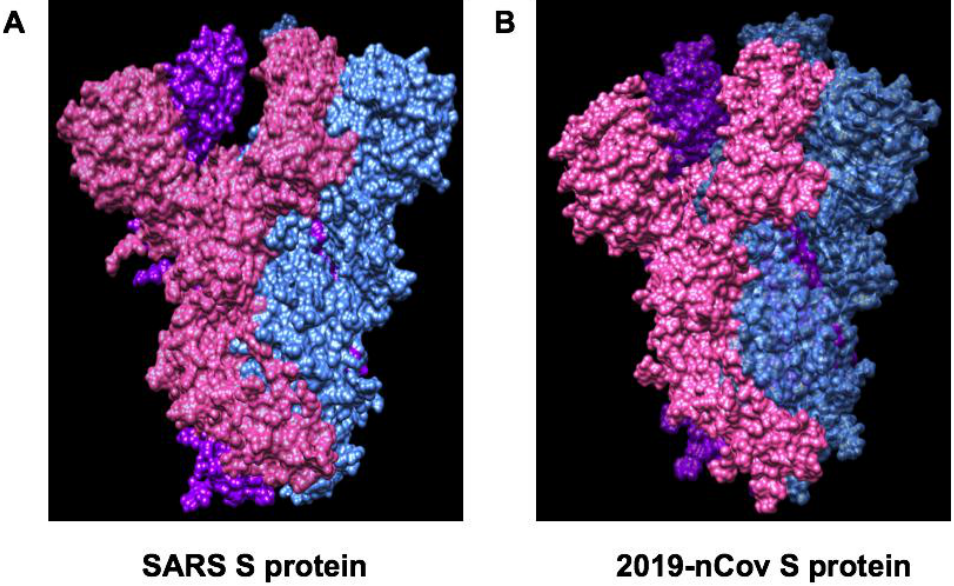
Figure 6. Comparison of Spike glycoprotein structures between SARS (PDB ID:6CRZ) and SARS-Cov-2 (PDB ID:6VSB). ( A ) SARS Spike glycoprotein is composed of NTD, RBD, SD1 and SD2, S2 subunit. The SARS-CoV S trimer is highlighted as a molecular surface with each protomer colored blue, pink or purple. ( B ) SARS-CoV-2 trimer is highlighted as a molecular surface with each protomer colored blue, pink or purple.